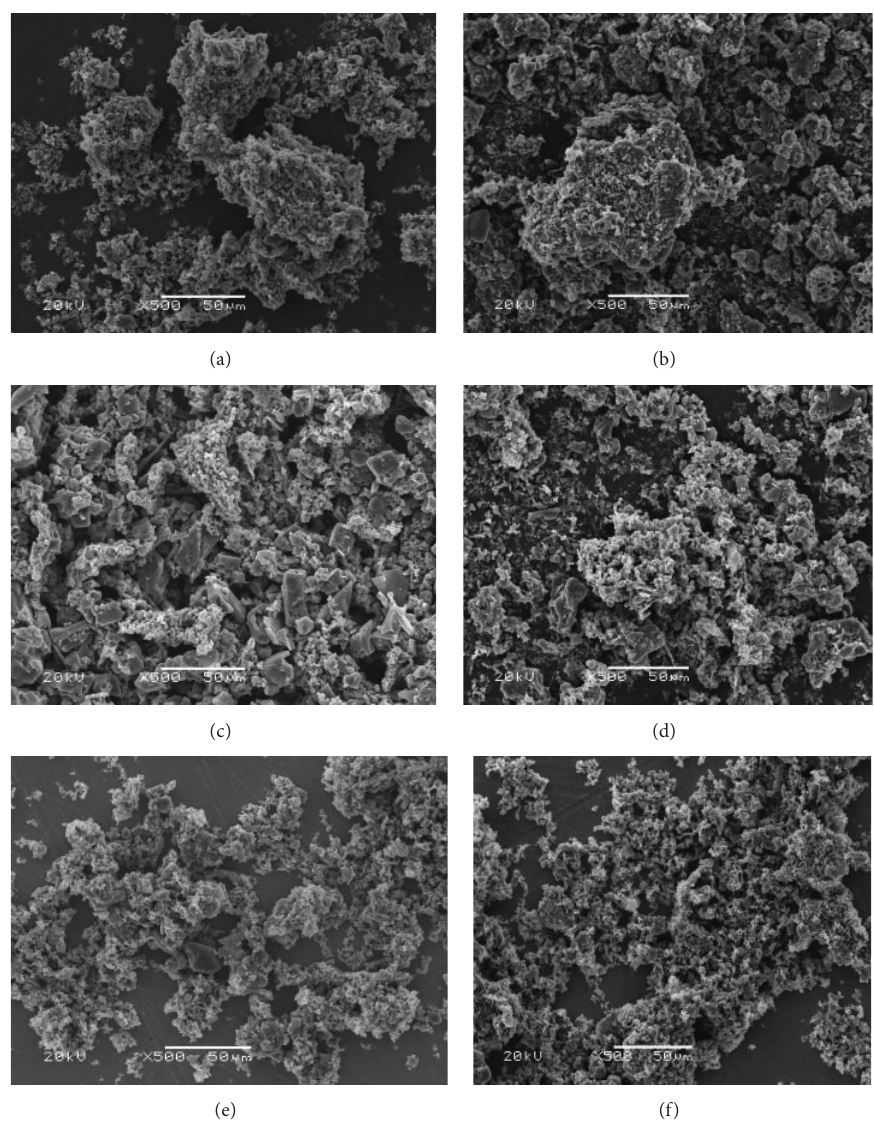
Figure 2: Morphologies of leached products obtained by salt-assisted SHS synthesis with different content of diluter. (a) 0% NaCl; (b) 10 wt%